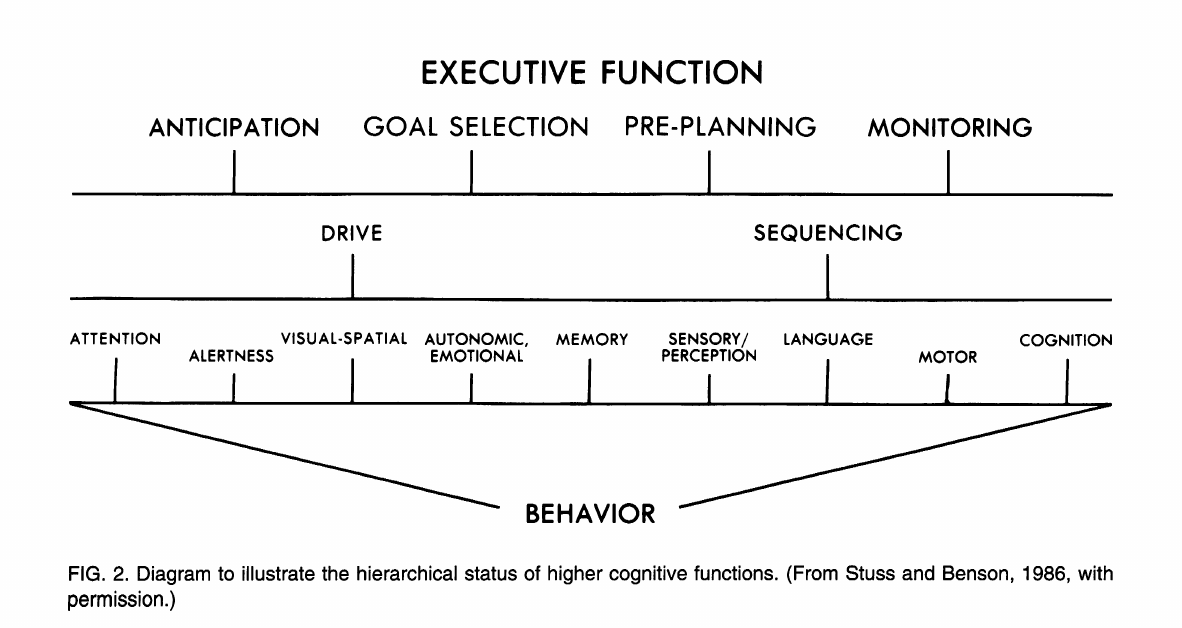
FIG. 2. Diagram to illustrate the hierarchical status of higher cognitive functions. (From Stuss and Benson, 1986, with